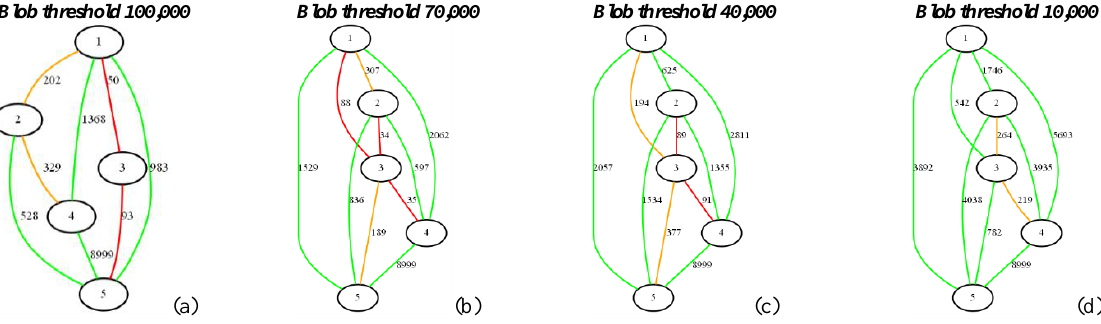
Figure 2. Connection graphs for the affine mapping function computed for different blob detection